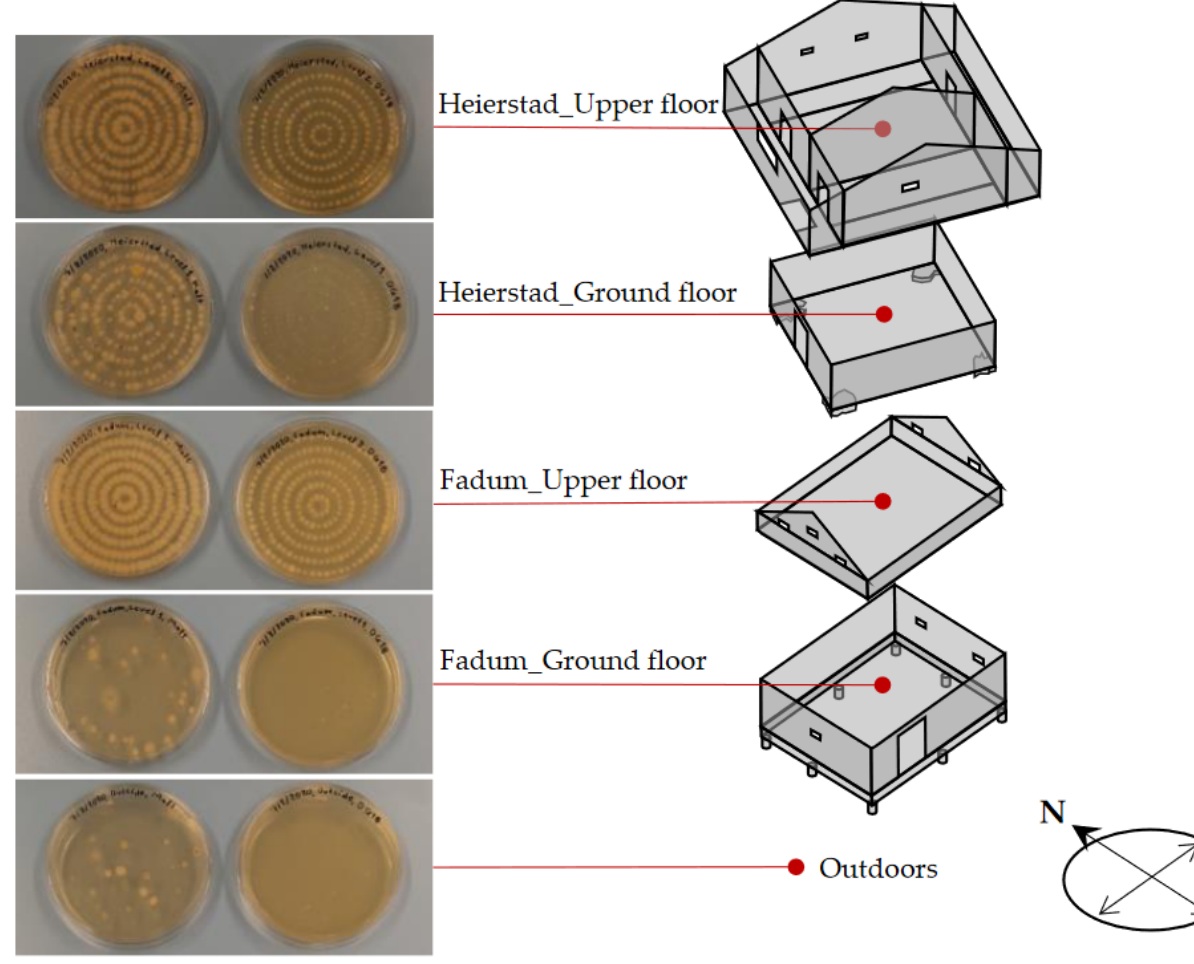
Figure 8. Positions of aerosol sampling and fungi colonies grown after 3 days at 25 °C on malt agar (plates on the left side of the pictures) and on DG-18 agar (plates on the right side of the pictures).